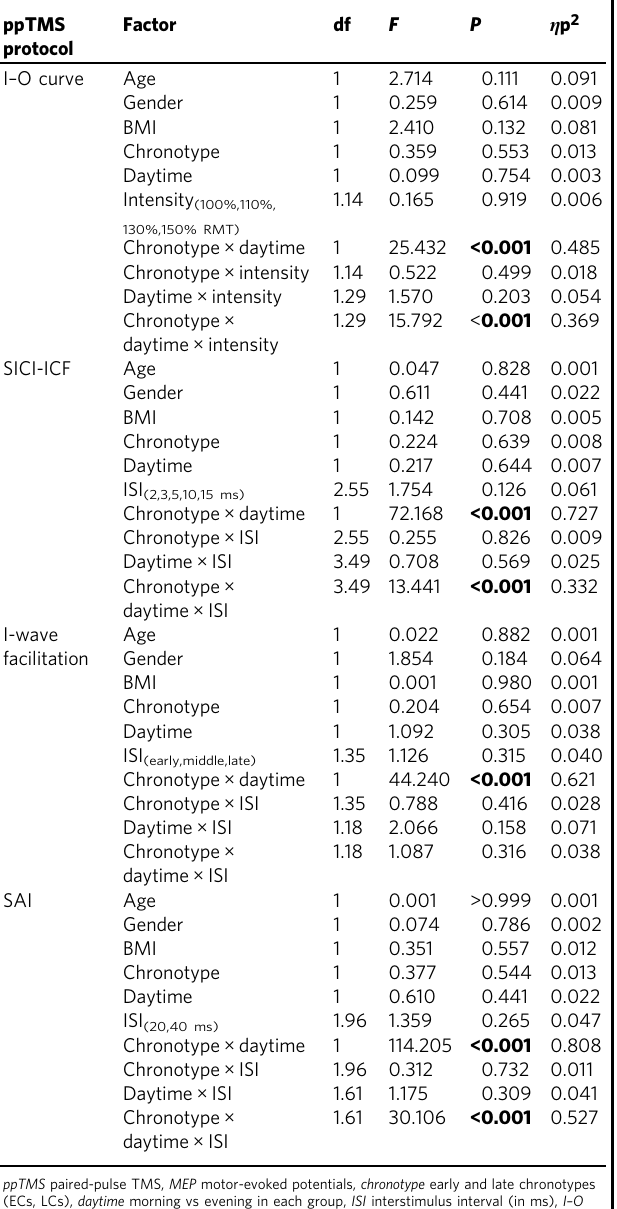
Table 1 The results of mixed-factorial ANOVAs for cortical excitability parameters measured via different TMS protocols.